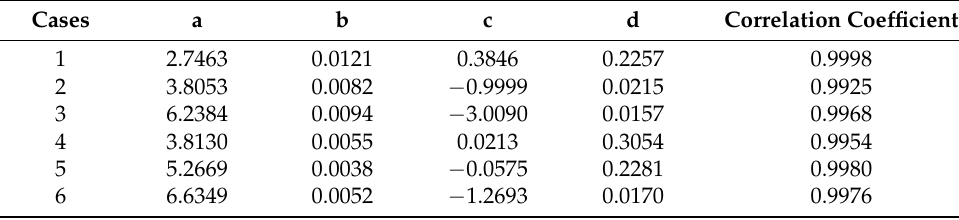
Table 3. The parameters in the